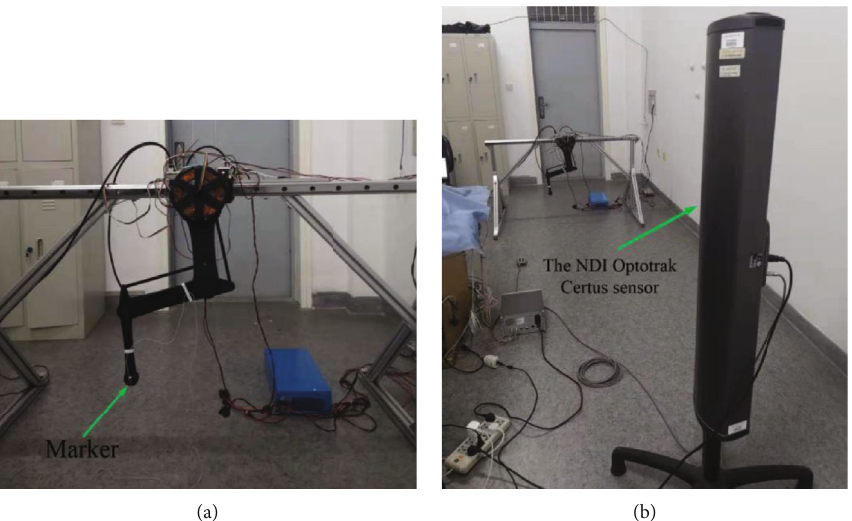
Figure 10: Experimental platform. (a) One leg experimental platform. (b) Trajectory measurement with the NDI Optotrak Certus sensor.